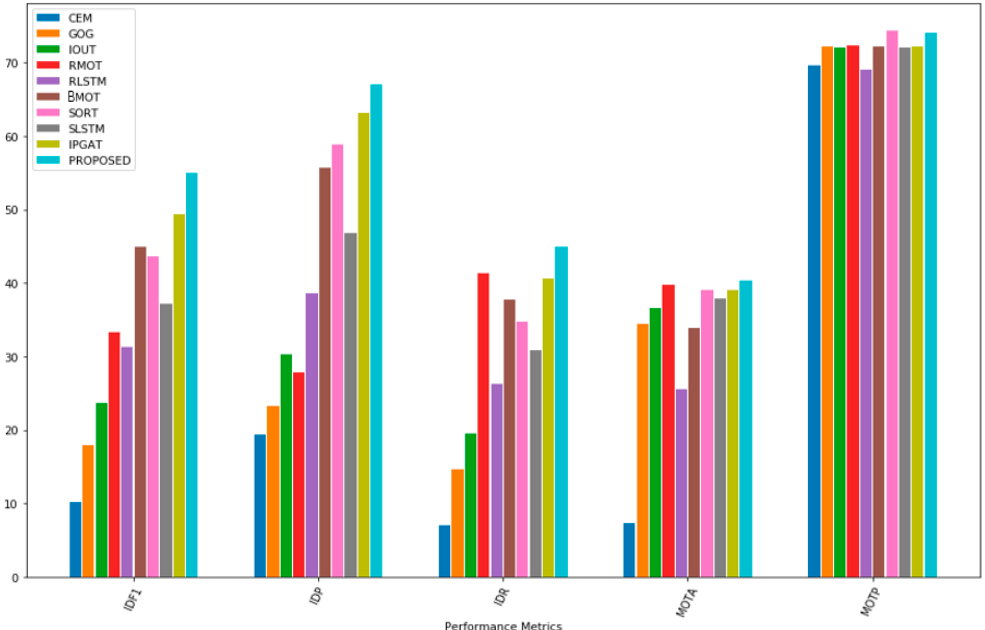
Figure 4. Comparative analysis of the proposed method with existing methods. CEM: continuous energy minimization, GOG: global optimal greedy, IOUT: intersection-over-union tracker, RMOT: relative motion online tracking, RLSTM: relative long short term memory, Bayesian multi-object tracking (BMOT), SORT: simple online and real-time tracking, SLSTM: social long short term memory.